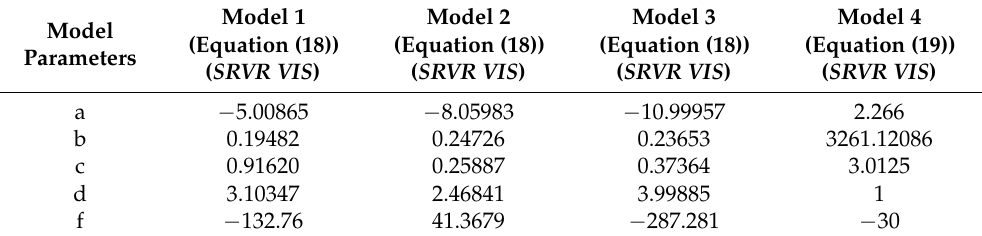
Table 10. Values of the SRVR viscosity model parameters of Models 1–4.